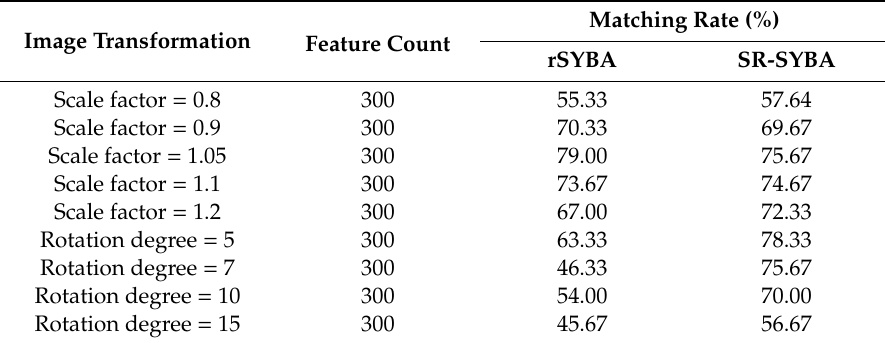
Table 1. Matching rate comparison between rSYBA and SR-SYBA.